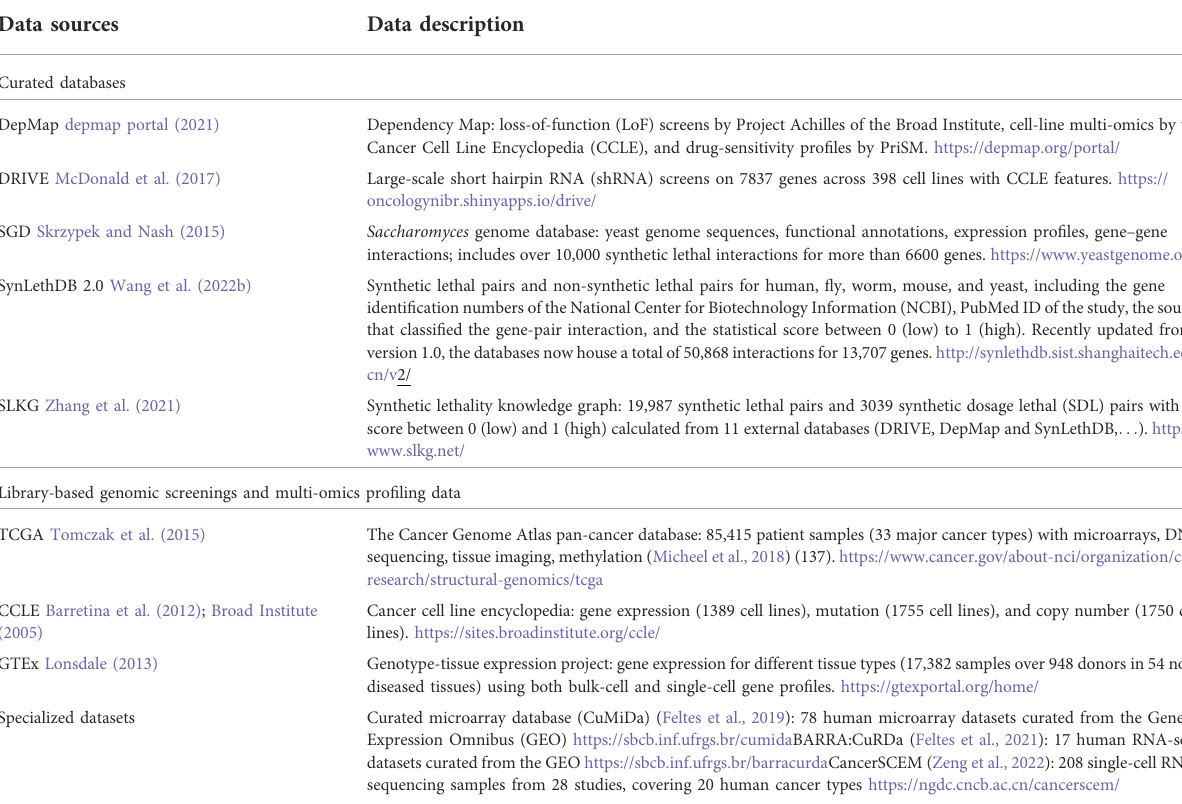
TABLE 1 Curated databases and library-based screening